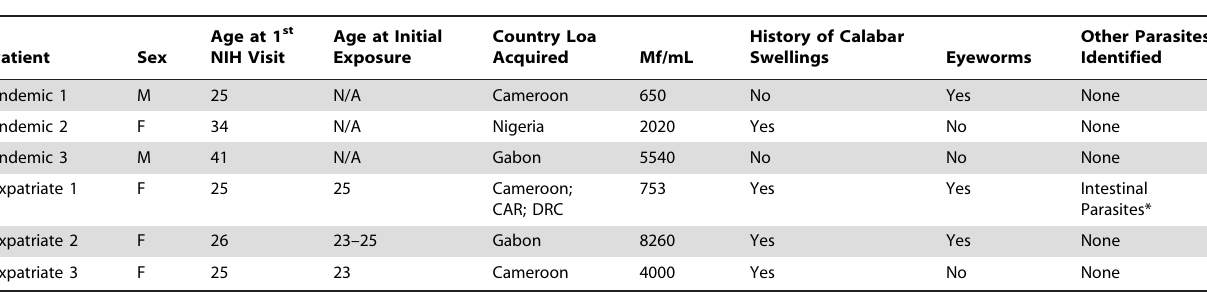
Table 1. Patient